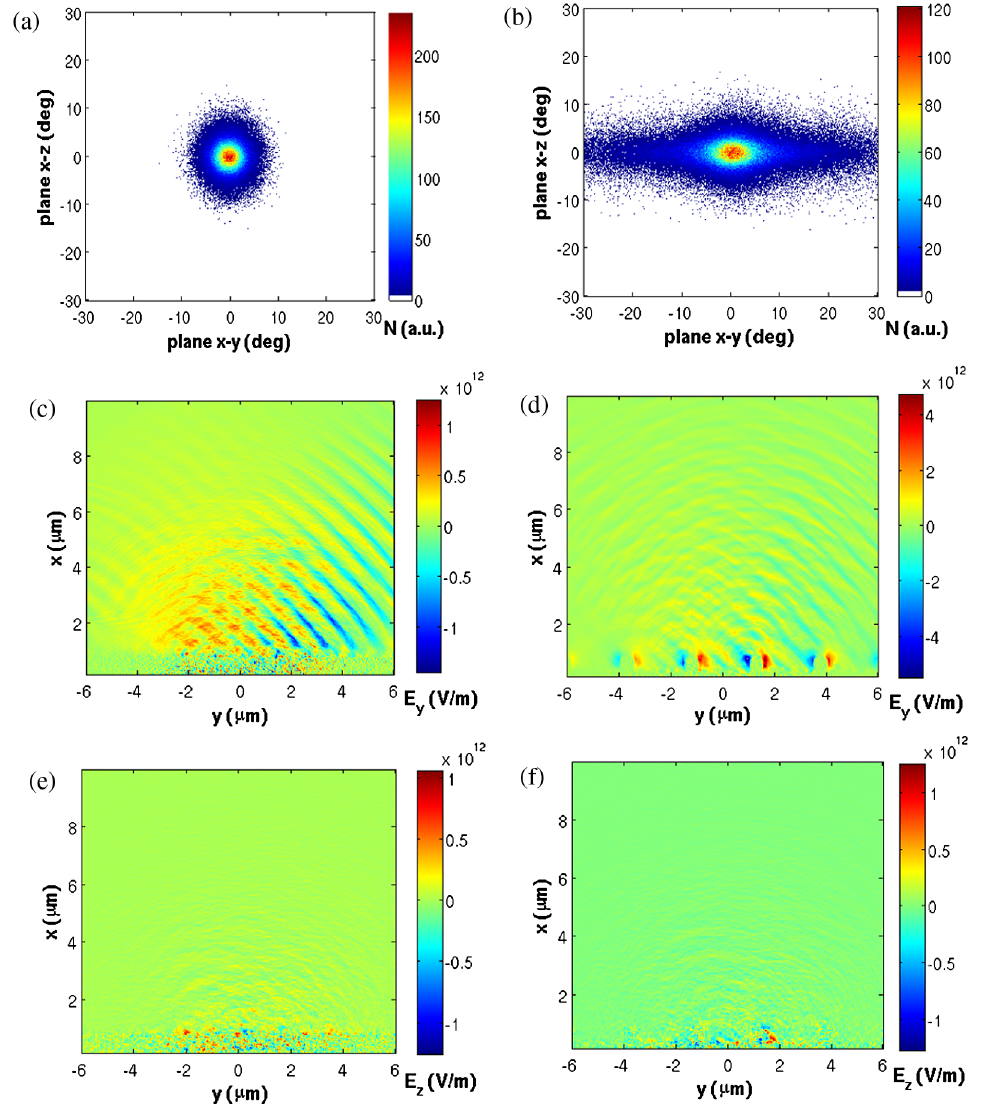
FIG. 6. Angular distribution of accelerated protons from 3D PIC simulations for SiN (a) and SiN 2 μ deflection angle from the target normal direction ( x axis) in the plane x − y ; vertical axis: deflection angle from the target normal direction ( x axis) in the plane x − z ; colorbar: number of numerical macroparticles per spatial angle in simulations. Electric field perpendicular to the grating orientation for SiN (c) and SiN 2 μ SiN 2 μ (f). The target front (laser-irradiated) surface is at x ¼ 0 , slightly outside the area shown in (c) – (f) (the laser comes from the m